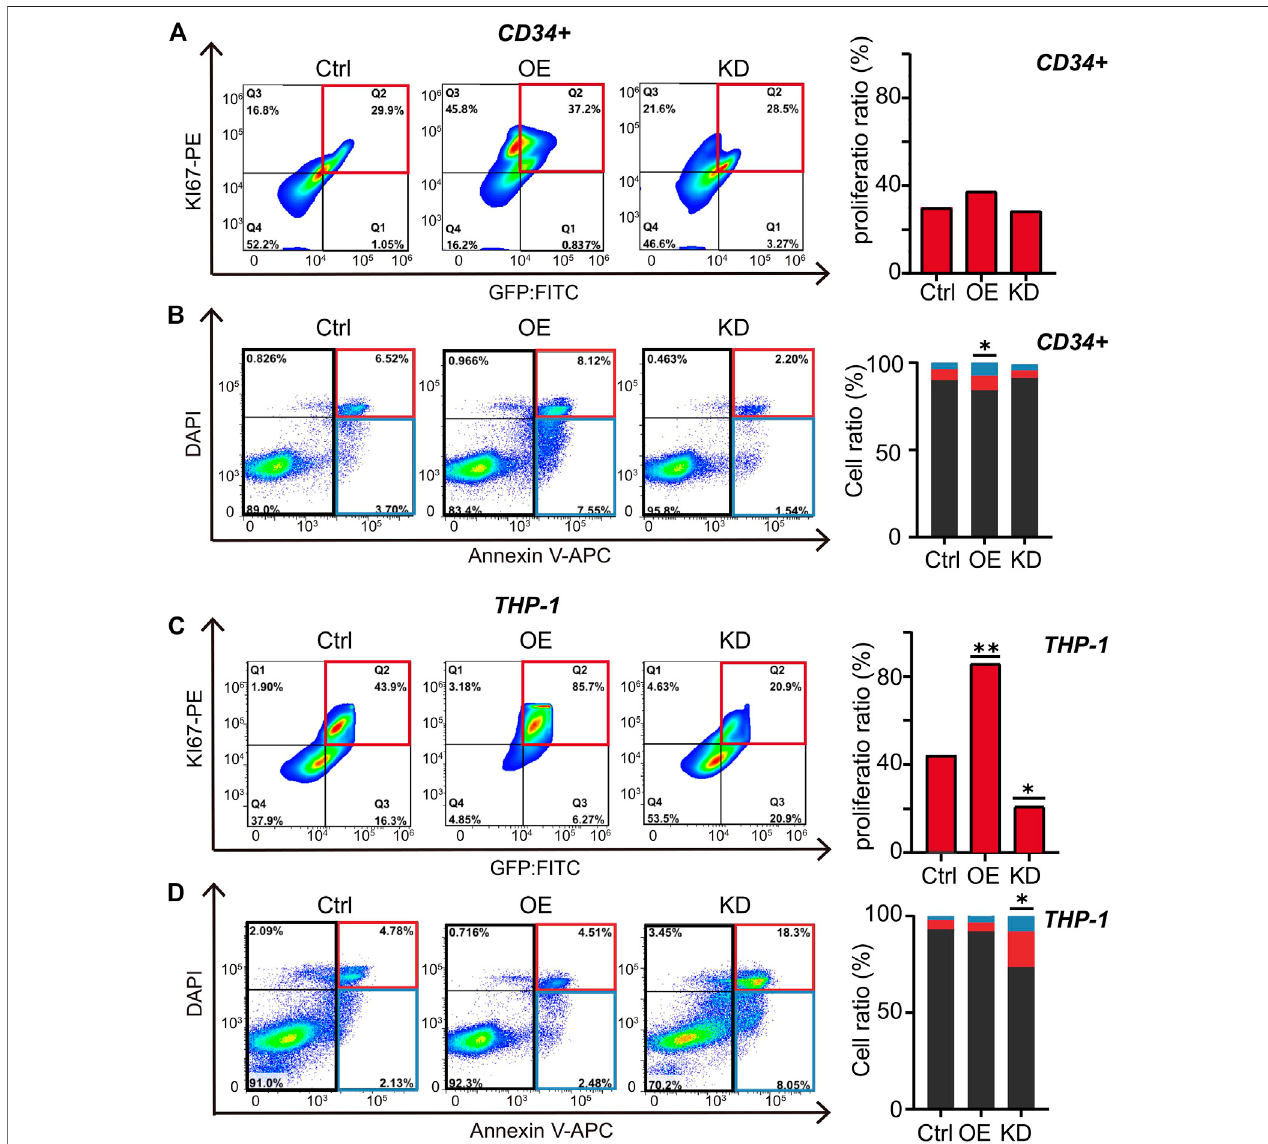
FIGURE 4 | RUNX1 promotes cell proliferation and inhibits cell apoptosis in leukemia cells. (A) FC analysis of cell proliferation in THP-1 cells. Flow plots (left) and histograms (right) show the proliferation ratio of THP-1 cells transducted with control, OE (RUNX1), and KD (RUNX1 shRNA). (B) . FC analysis of cell apoptosis in THP-1 cells. Flow plots (left) and histograms (right) show the apoptosis (blue and red box) and active cell (black box) ratio. The cell proliferation in (C) and apoptosis in (D) in CD34 + cells were similar described with (A,B) . (one-way ANOVA, * p < 0.05, ** p < 0.01,*** p < 0.001; error bars, median ±